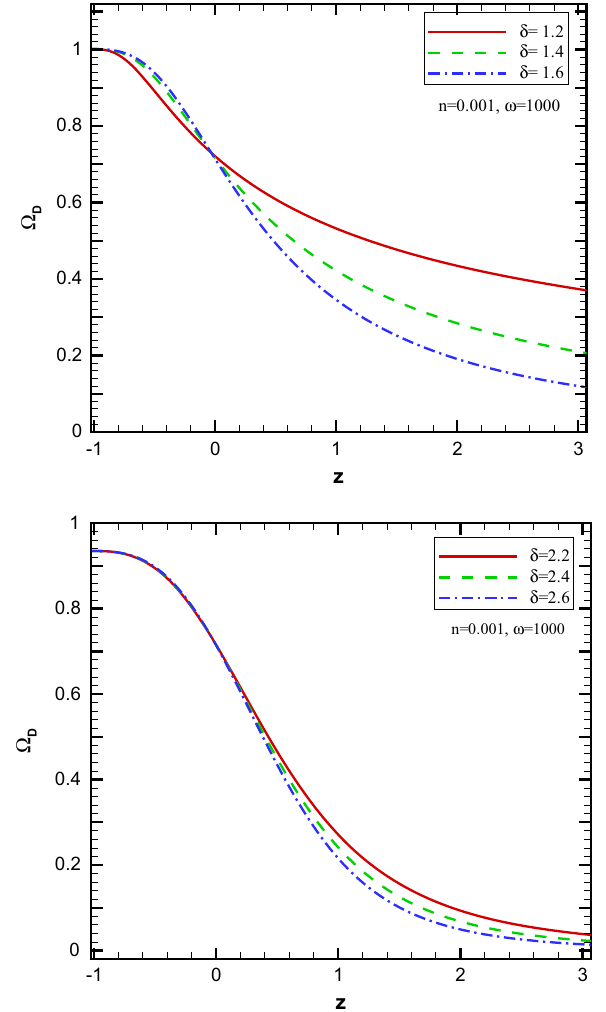
Fig. 1 (cid:3) D versus z . Here, we used (cid:3) k = 0 (upper panel), (cid:3) k 0 = 0 . 1 (lower panel), (cid:3) D 0 = 0 . 73, n = 0 . 001 and ω = 1000 [19] as the initial